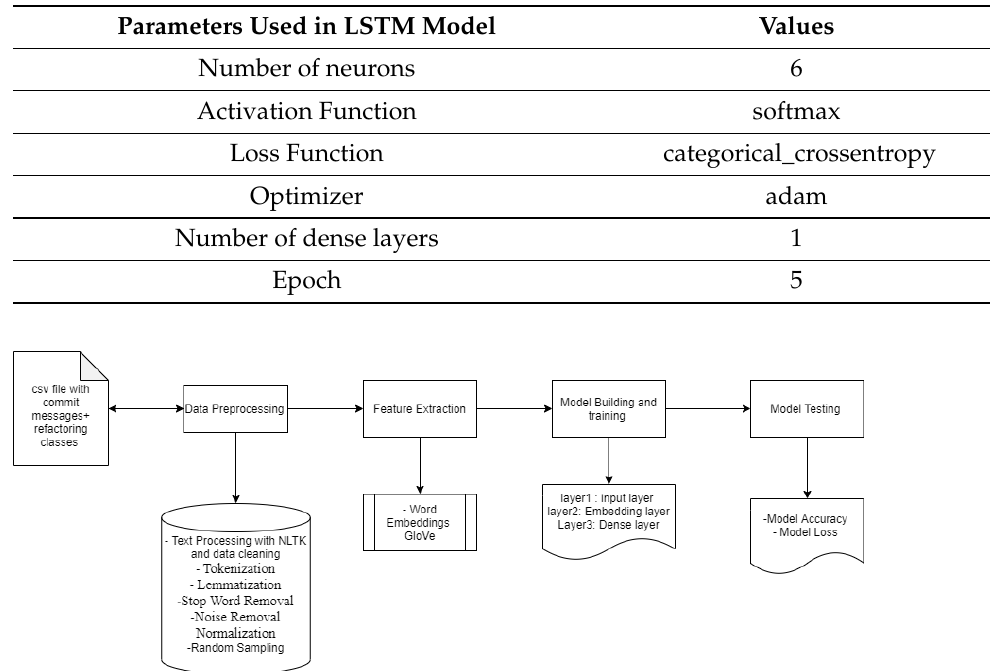
Table 3. Parameter hypertuning for LSTM model.